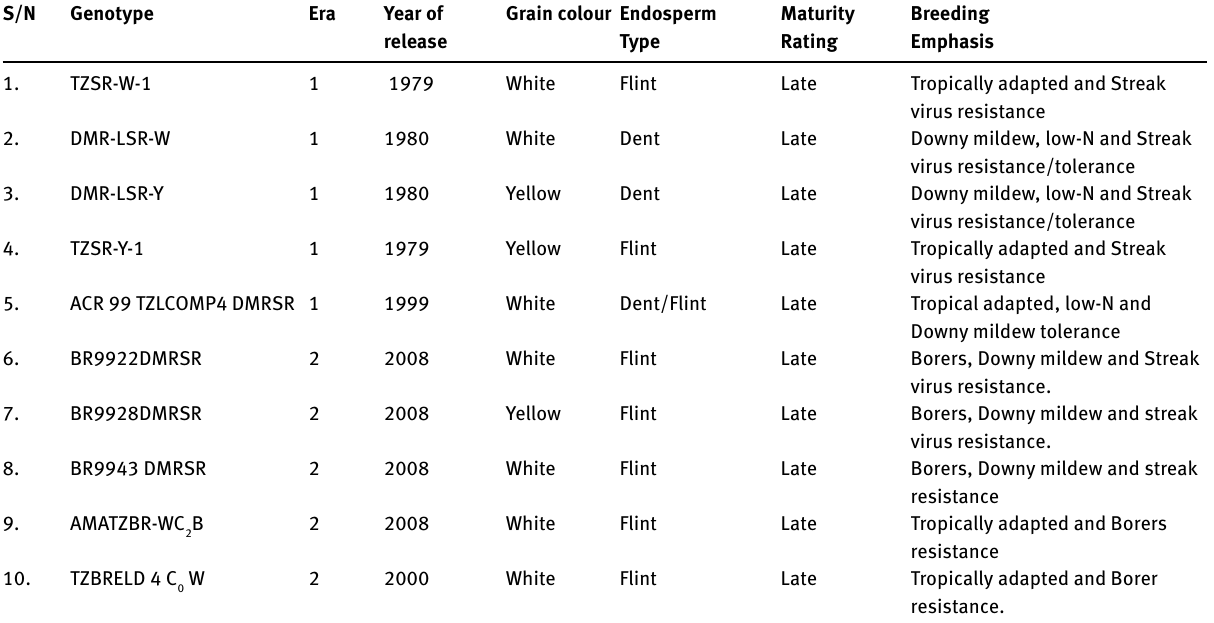
Table 1: Characteristics of ten maize varieties representing two Eras of maize breeding in Nigeria S/N